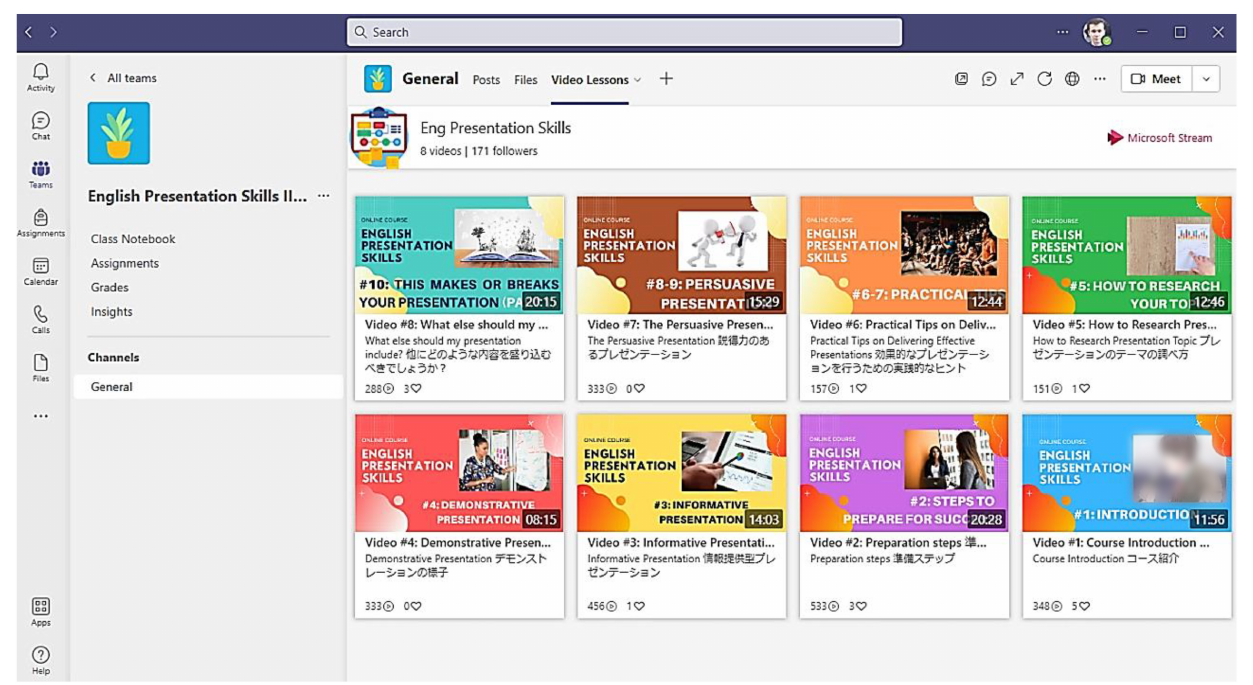
FIGURE 2 | Microsoft TeamsTM—based course LMS. Microsoft and Microsoft Teams are trademarks of the Microsoft group of companies.